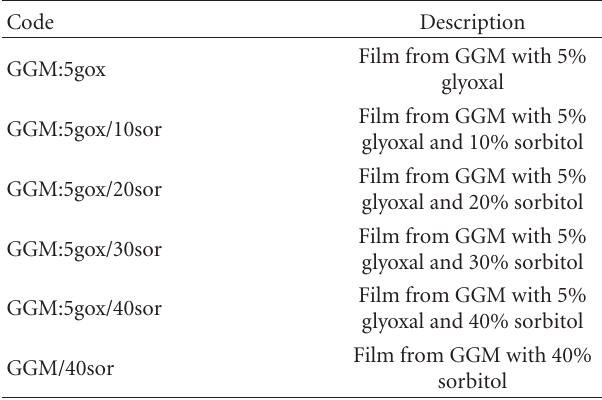
Table 1: Film codes. The percentages are wt.-% of